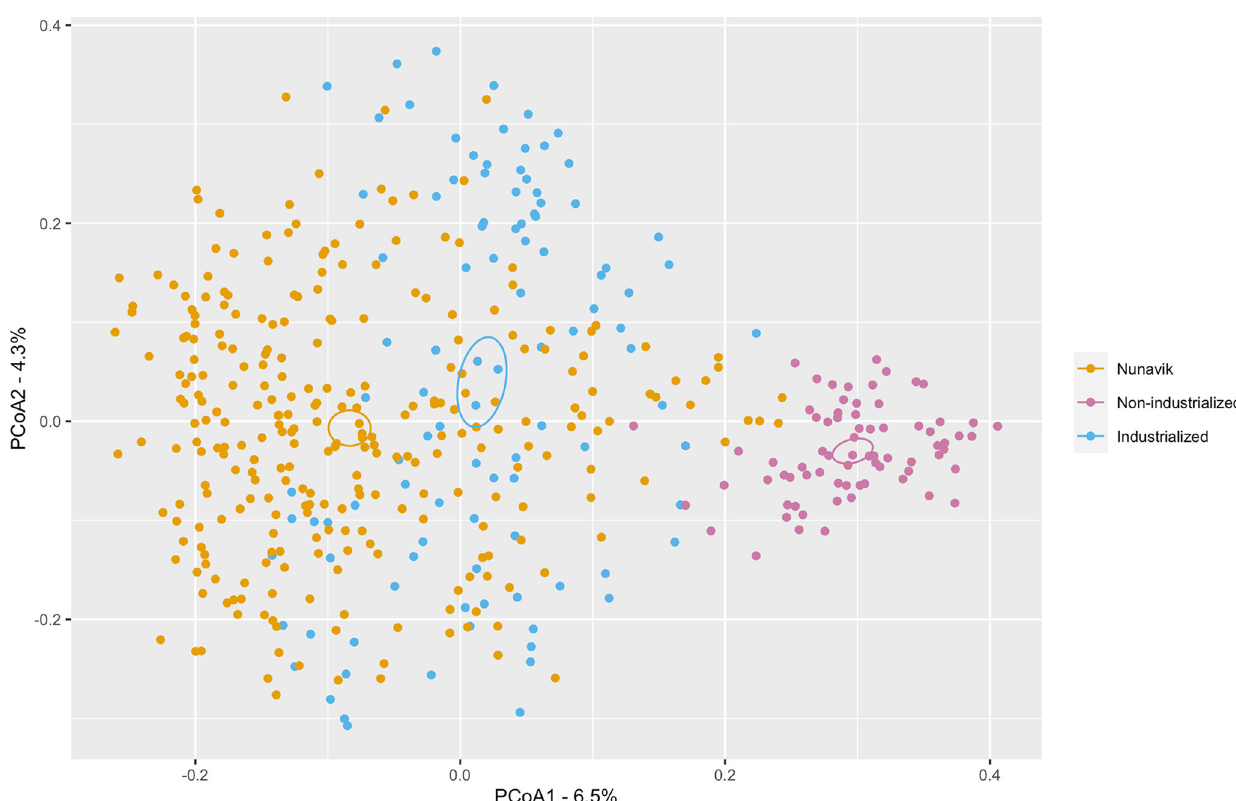
Fig. 2 PCoA on Bray-Curtis dissimilarity of the microbiome in Nunavik Inuit, in individuals from non-industrial and industrial societies. PCoA on Bray- Curtis dissimilarity shows signi fi cant separation between species composition from Nunavik, compared to non-industrial ( n = 73) and industrial ( n = 104) populations. Ellipses represent the barycenter of the sample groups with their 95% con fi dence interval. PERMANOVA was used to evaluate signi fi cance of lifestyle ( R 2 = 0.06431, p -value = 0.001). Age and sex had a minor effect on the observed variance (age; R 2 = 0.00440, p -value = 0.001, sex; R 2 = 0.00423, p -value = 0.001). Analysis of Similarities (ANOSIM) demonstrated signi fi cant differences between groups based on lifestyle (lifestyle, R = 0.5103, p -value = 0.001; age, R = − 0.002, p -value = 0.565; sex, R = 0.028, p -value =